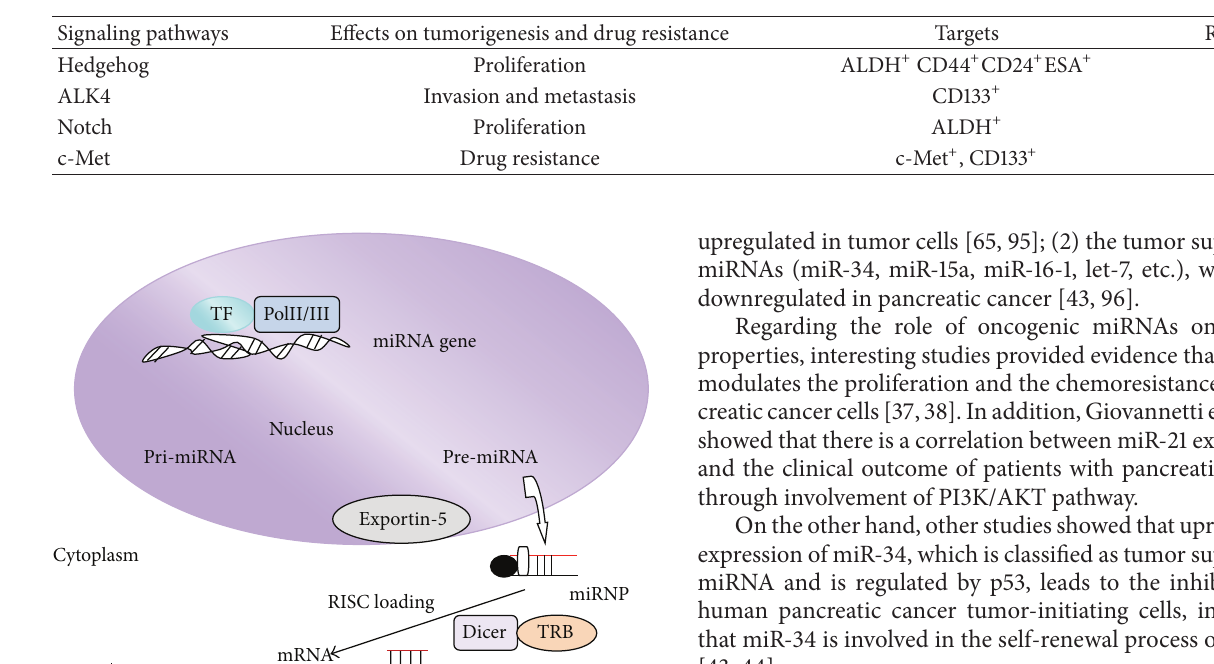
Table 1: Self-renewal pathways in PCSCs.